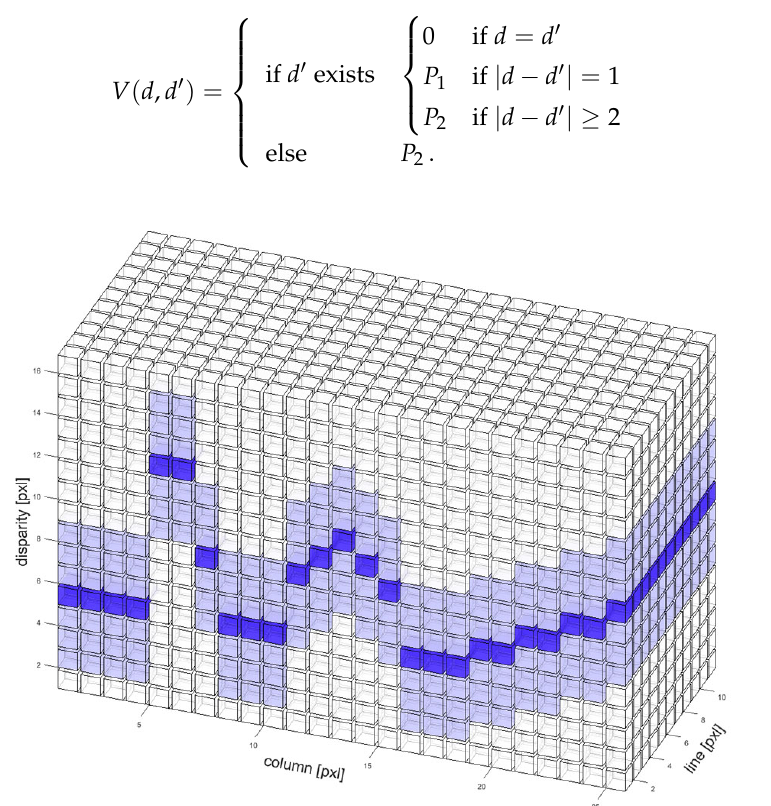
Figure 10. Cost volume C p ( d ) of classical SGM versus our implementation is shown on a toy example. While SGM evaluates the whole cost volume, we only check the disparities visualized in light blue color around the disparity predictions from the previous pyramid level depicted in dark blue color. In